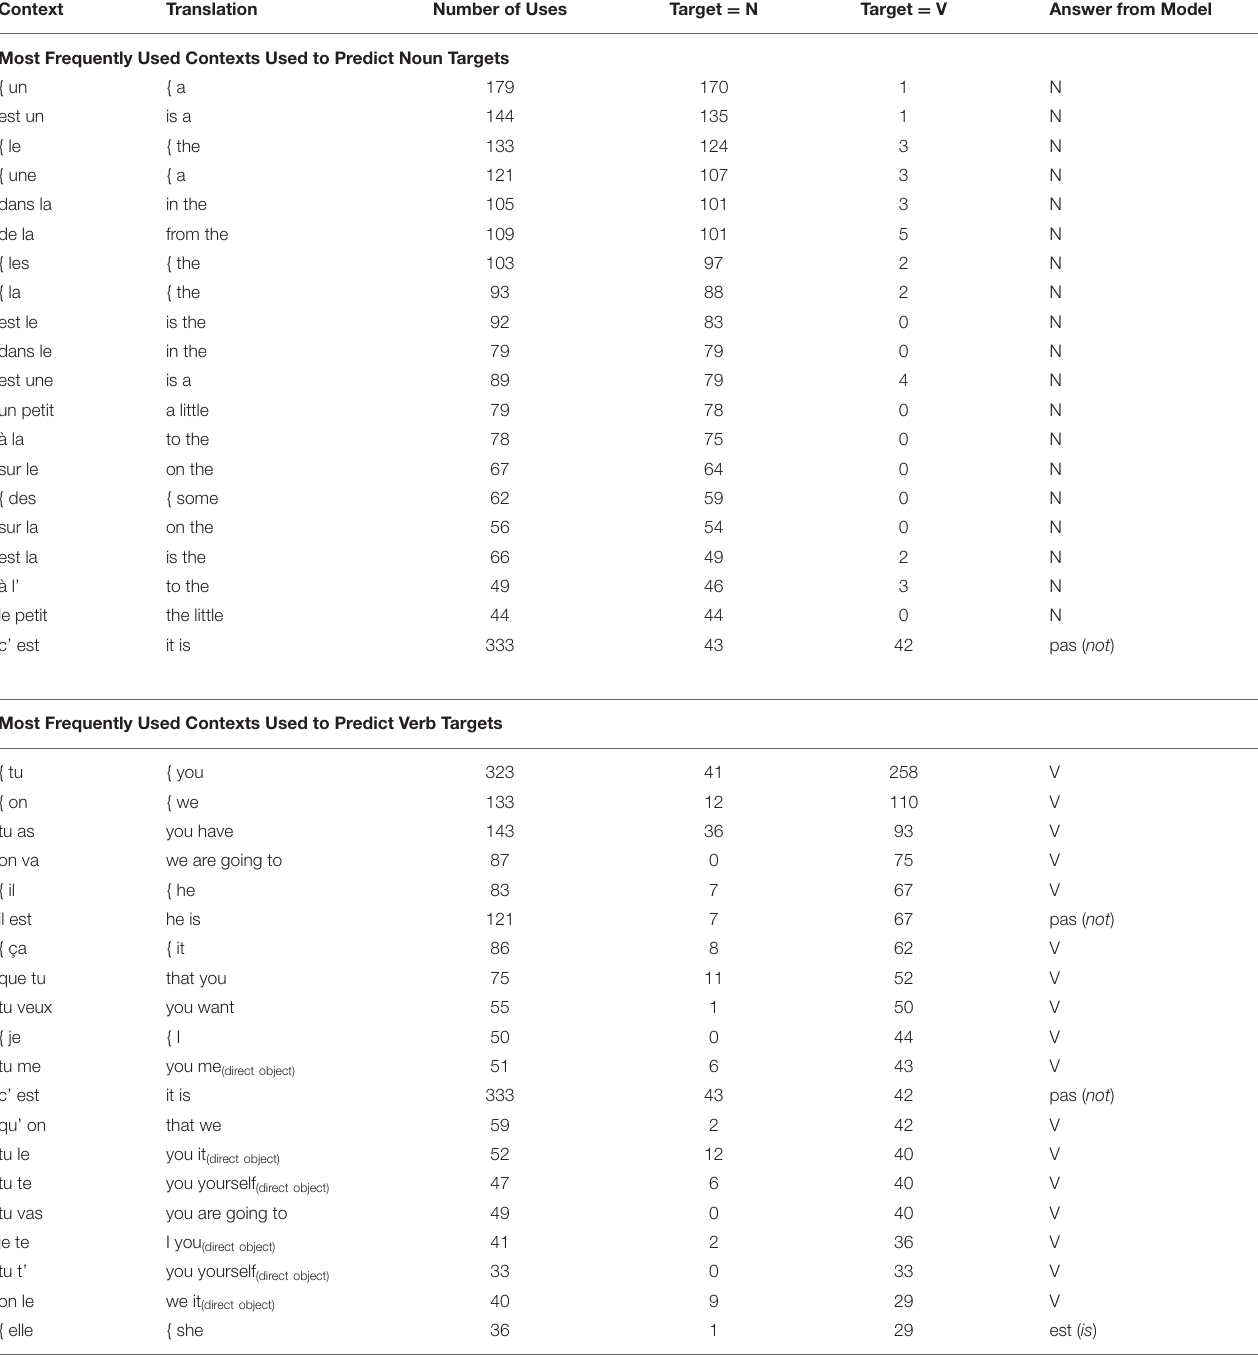
TABLE 4 | Most frequent contexts used by the left context model during categorization, with a maximal projection (Vm). Context Translation Number of Uses Target = N Target = V Answer from